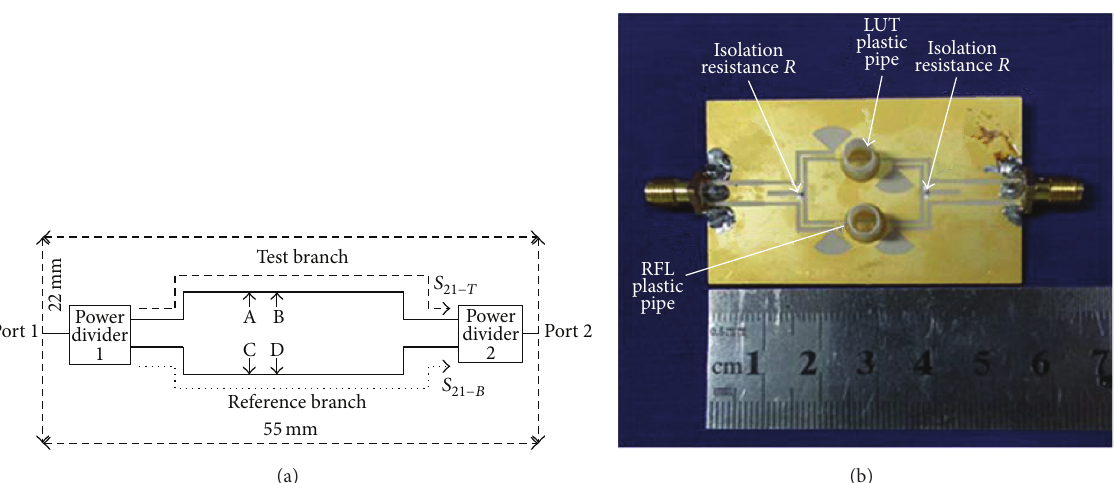
Figure 1: (a) Schematic of the proposed high sensitive sensor. (b) Fabricated sensor with plastic